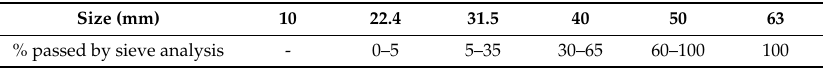
Table 1. Size distribution of the gravel for track ballast used in Korea [18].